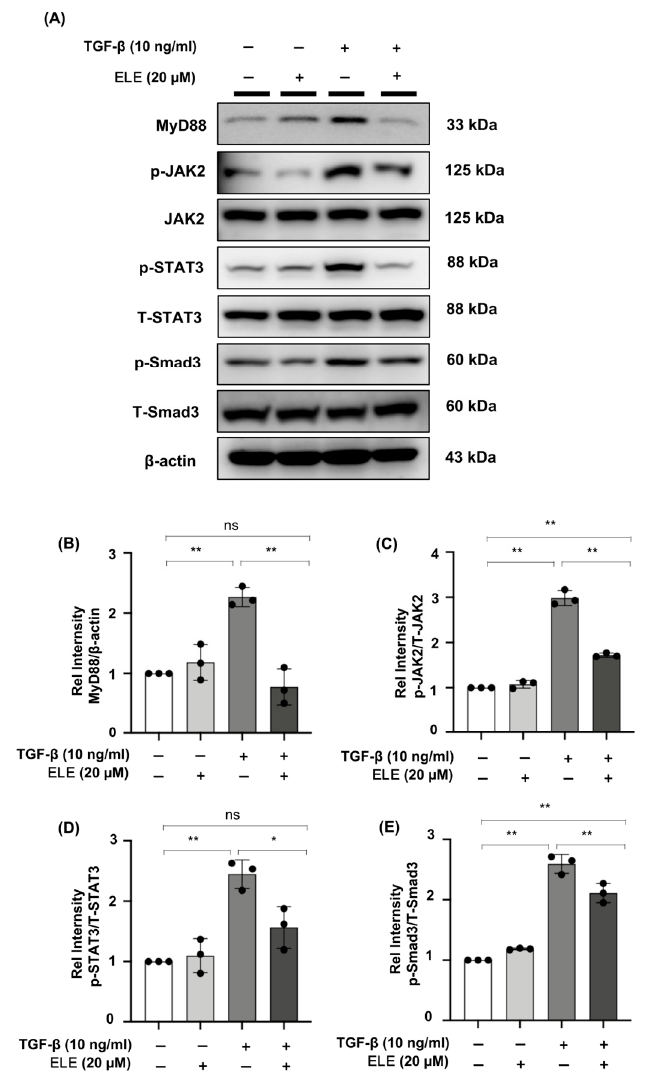
Figure 5. β -elemene down-regulated the phosphorylation of JAK2/STAT3 and Smad3 and inhibited the expression of MyD88 in TGF- β -stimulated NRK49F cells. ( A ) Expression of MyD88, p-JAK2, JAK2, p-STAT3, T-STAT3, p-Smad3, and T-Smad3 in TGF- β stimulated NRK49F cells was detected by western blot and quantified by densitometry. Cells were pre-treated with β -elemene for 2 h after starvation with 0.5% FBS medium and then treated with TGF- β (10 ng/mL) for 30 min. ( B – E ) Statistical significance was presented as the mean ± SD, n = 3. * p < 0.05, ** p < 0.01, ns: no significance. ELE, β -elemene. 2.6. The STAT3 Inhibitor, NSC, and the Smad3 Inhibitor, SIS3 Reduced the Expression of Fibrotic Markers in TGF- β -Stimulated NRK49F Cells Specific STAT3 phosphorylation inhibitor NSC and Smad3 phosphorylation